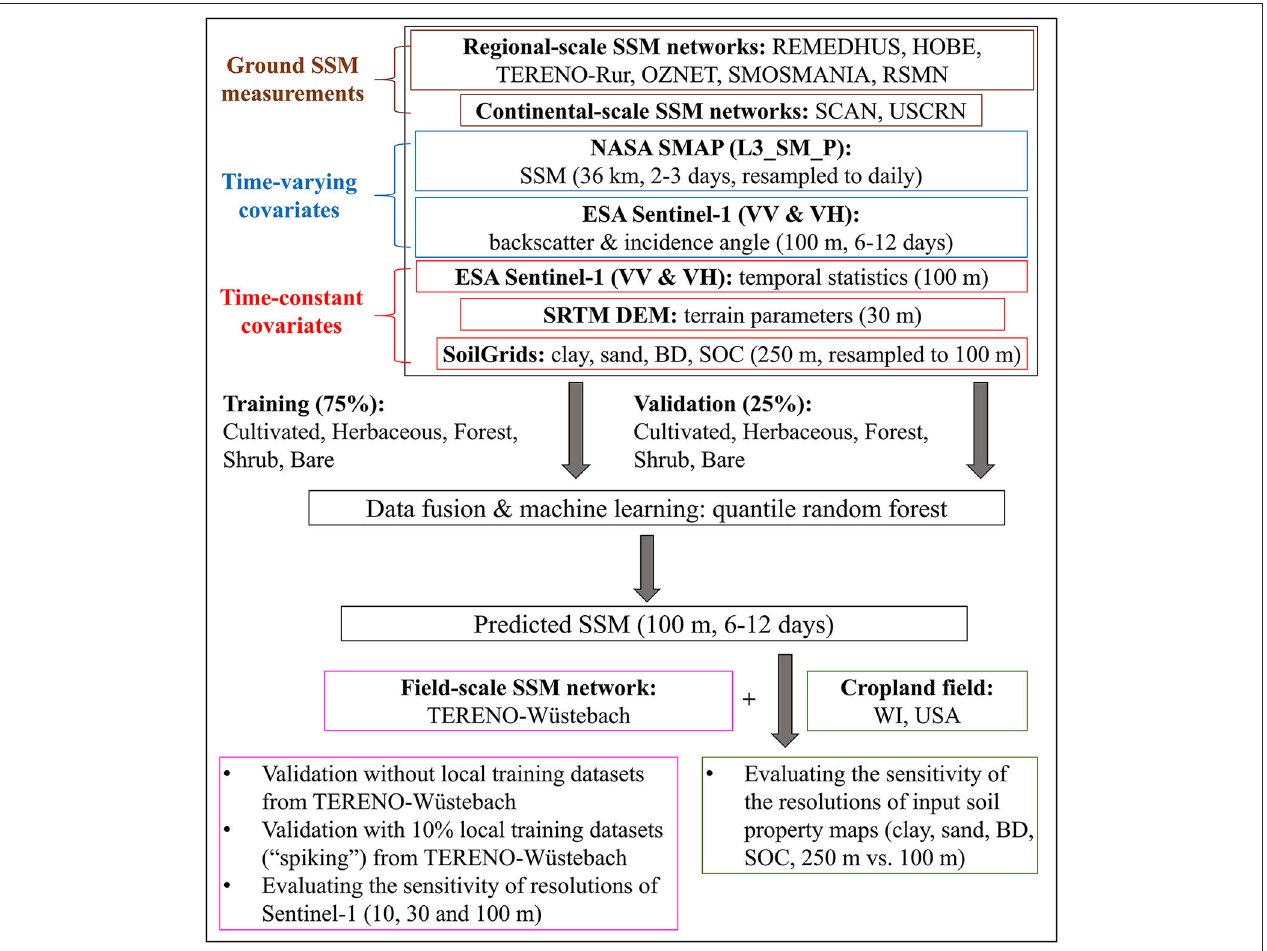
FIGURE 2 | Flowchart of the global surface soil water model established using data fusion and machine learning and different evaluation